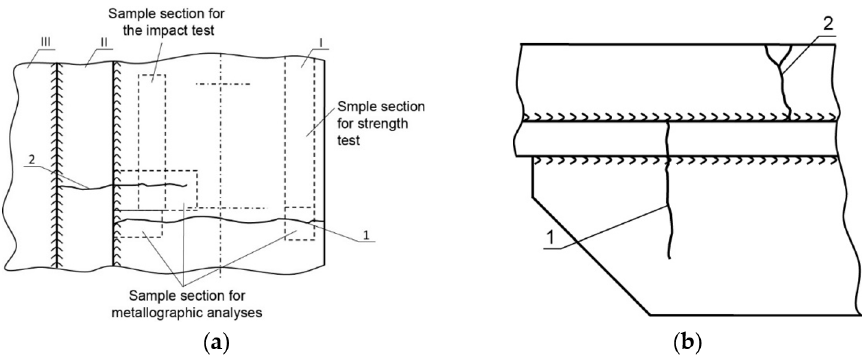
Figure 12. The picture of y cracks in a manhole from a handy-size bulk carrier 30206 DWT: ( a ) Y-view and ( b ) X-view.